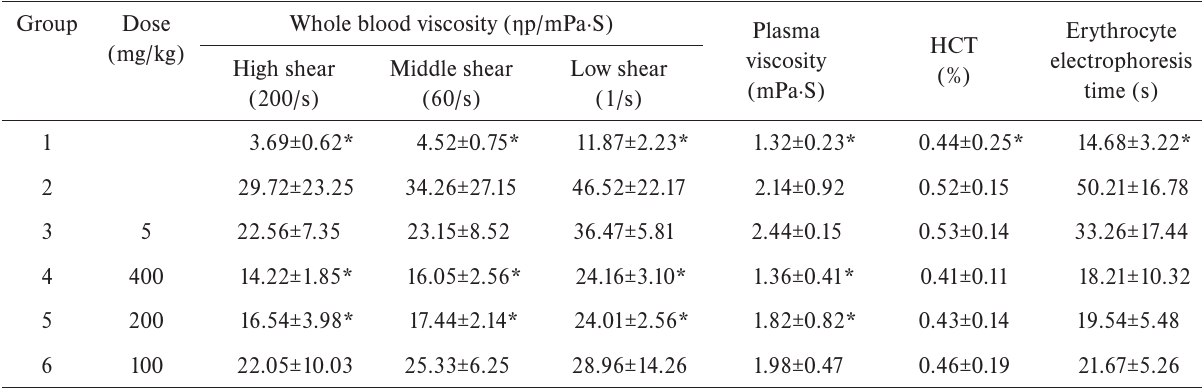
Table 2. Effects of puerarin on blood rheology (M ± Q).